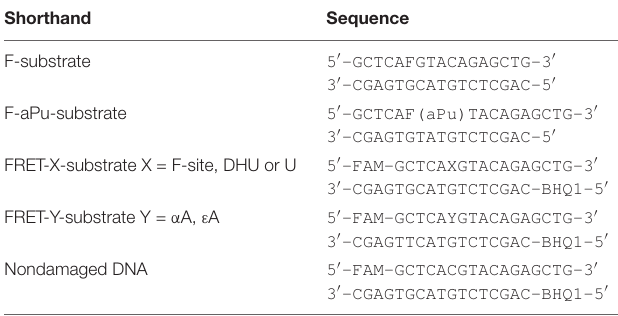
TABLE 1 | DNA substrates used in this